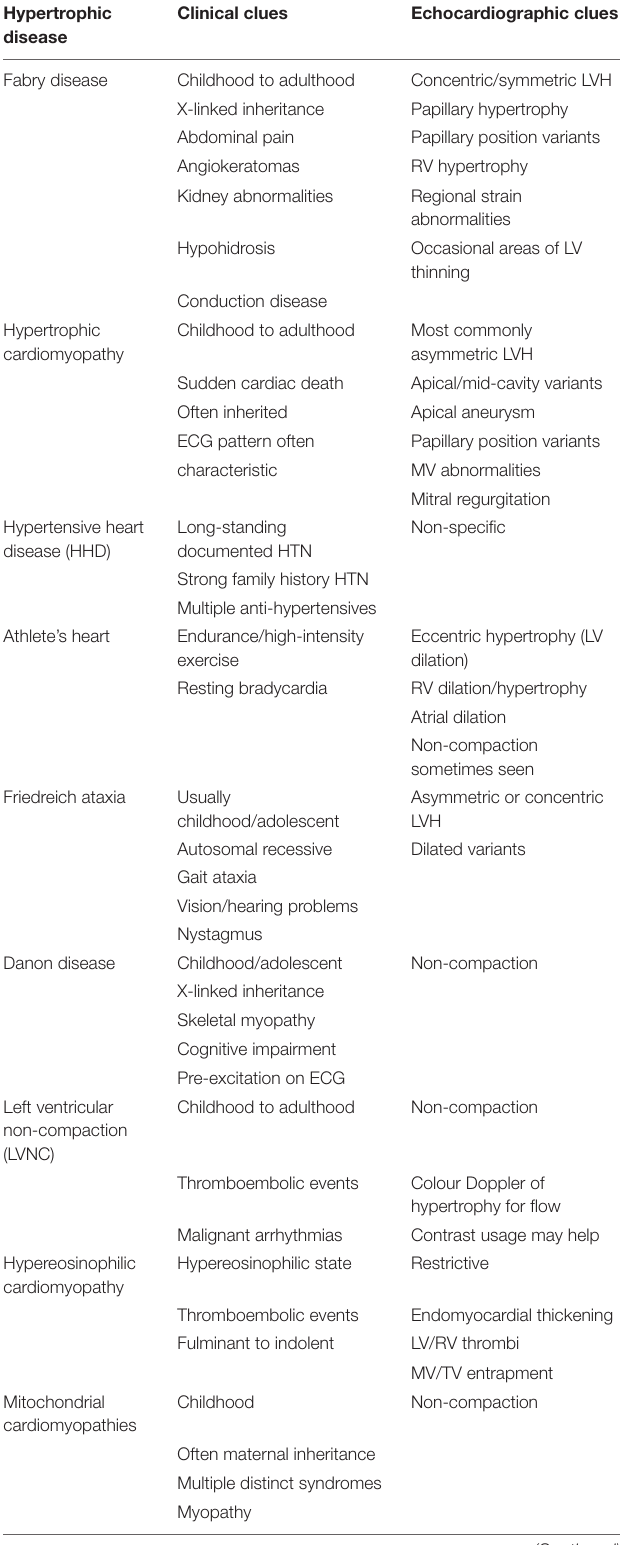
TABLE 3 | Clinical and echocardiographic characteristics of alternative causes of left ventricular hypertrophy beyond cardiac amyloidosis. Hypertrophic Clinical disease